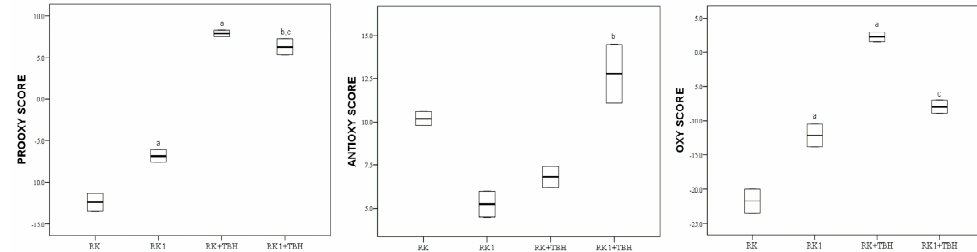
Figure 5. Values of pro-oxidative, antioxidative and oxidative scores of raspberry ketone (RK) and its dimer (RK1) in serum pool before and after the addition of TBH; values are represented by median (horizontal line) and interquartile range (25–75th percentile (lower and upper edge, respectively)). a,b,c,—significant difference ( p < 0.05) compared to RK, RK1, RK + TBH, respectively.